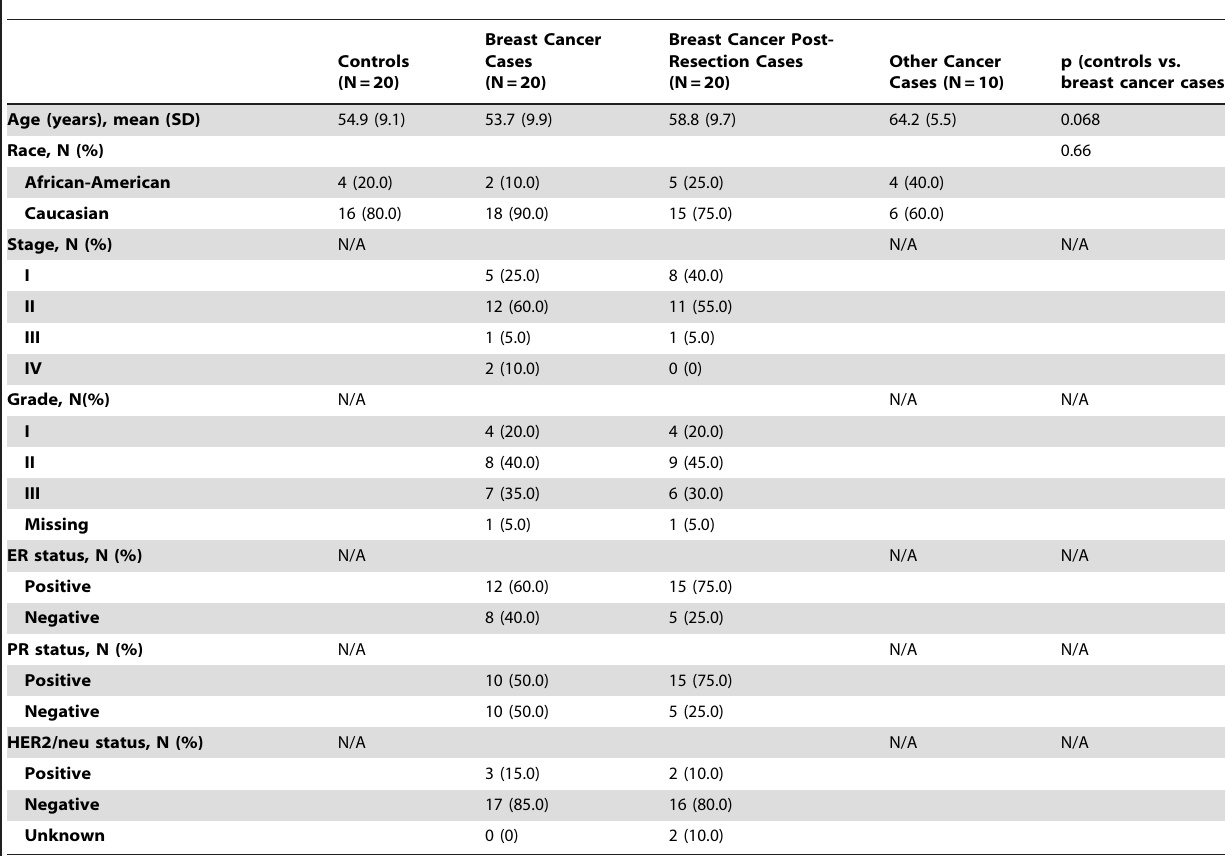
Table 3. Current Study Population